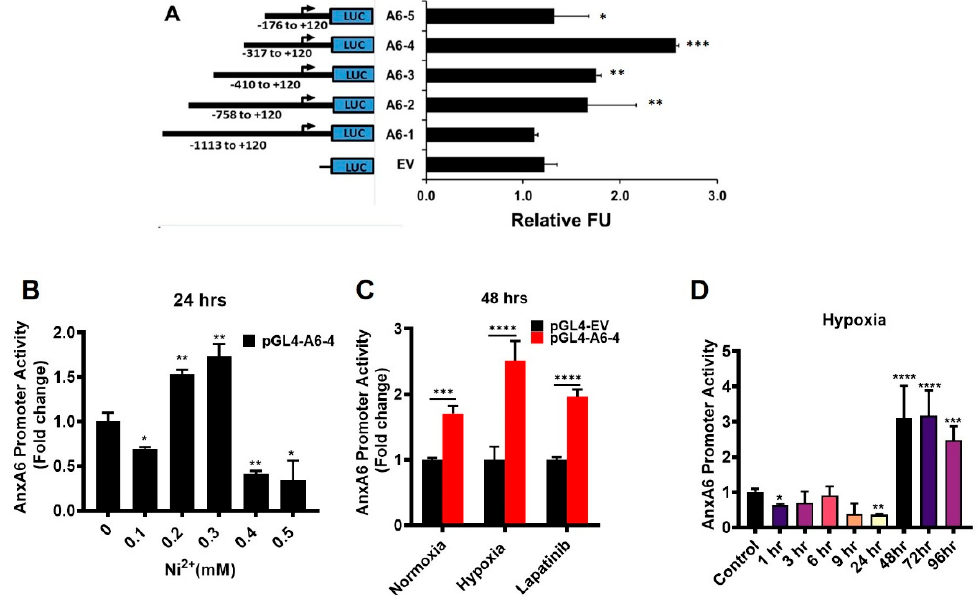
Figure 3. The Proximal AnxA6 promoter is responsive to Hypoxia. ( A ) The proximal promoter of AnxA6 was truncated as indicated and cloned into pGL4 basic, then used to transfect HEK293T cells and the luciferase activity was assayed following treatment of the cells with 0.3 mM Ni 2+ for 24 h using the dual luciferase assay kit. Renilla luciferase expressing vector was used as the transfection control. ( B ) HEK293T cells transfected with pGL4-A6-4 promoter were treated with the indicated concentrations of Ni 2+ for 24 h followed by luciferase assay. ( C ) HEK293T cells transfected with EV and pGL4-A6-4 promoter were cultured under normoxia, hypoxia, with or without lapatinib (2 µM) treatment and luciferase activity was assays as in ( A ) above. ( D ) HEK293T cells transfected with pGL4-A6-4 promoter were cultured in hypoxic conditions for up to 96 h followed by luciferase assays. All data are presented as mean ± SEM, n = 3 . Asterisks (* p ≤ 0.05; ** p ≤ 0.01; *** p ≤ 0.001; **** p ≤ 0.0001). p- values were analyzed by One-way ANOVA.